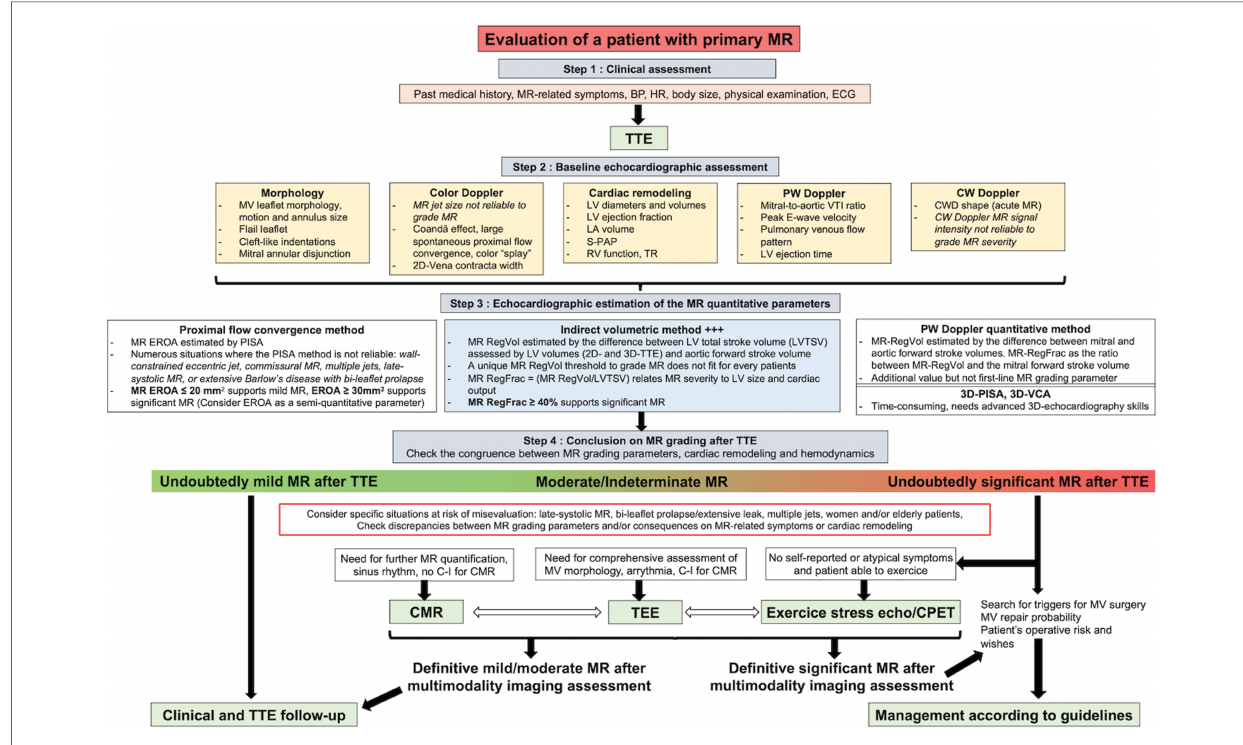
FIGURE 1 Central algorithm of the echocardiographic assessment of a patient with primary MR. Freely inspired by Zoghbi et al and Hagendorff et al. (23, 28). 2D, two-dimensional; 3D, three-dimensional; BP, blood pressure; CMR, cardiac magnetic resonance; CPET, cardiopulmonary exercice testing; CWD, Continuous-Wave Doppler; ECG, electrocardiogram; EROA, effective regurgitant ori fi ce area; LA, left atrial; LV, left ventricular; MR, mitral regurgitation; MV, mitral valve; PISA, proximal isovelocity surface area; RegFrac, regurgitant fraction; RegVol, regurgitant volume; RV, right ventricular; S-PAP, systolic pulmonary artery pressure; TR, tricuspid regurgitation; TSV, total stroke volume; TTE, transthoracic echocardiography; TEE, transesophageal echocardiography; VCA, vena contracta area; VTI, velocity-time